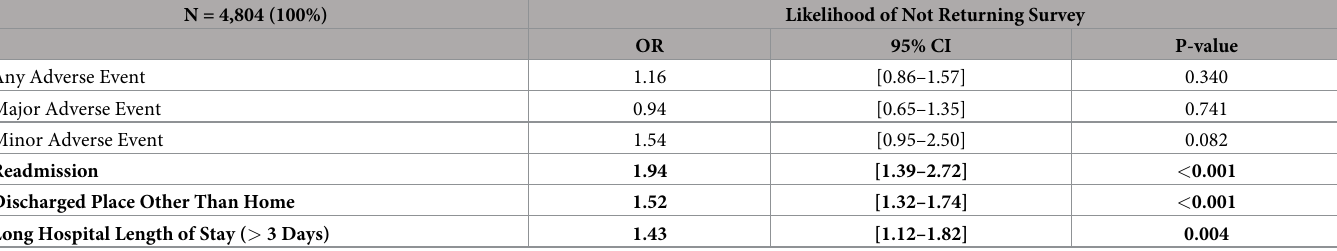
Factors in Model: All Factors in Tables 1 and